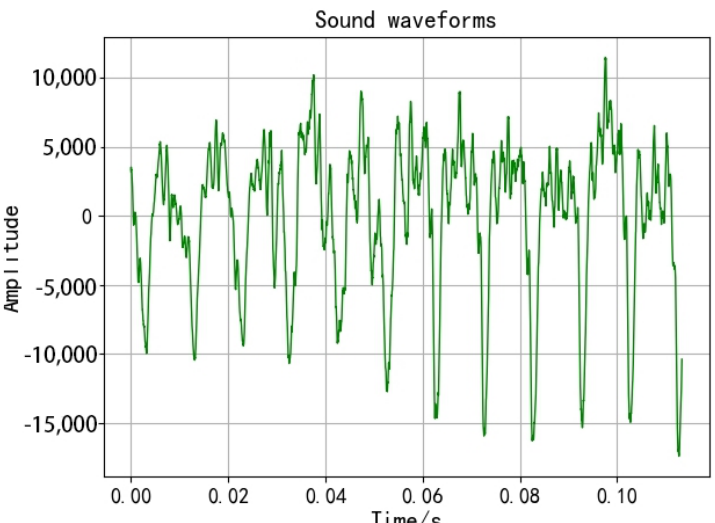
Figure 2. Discharge state time domain waveform plot.